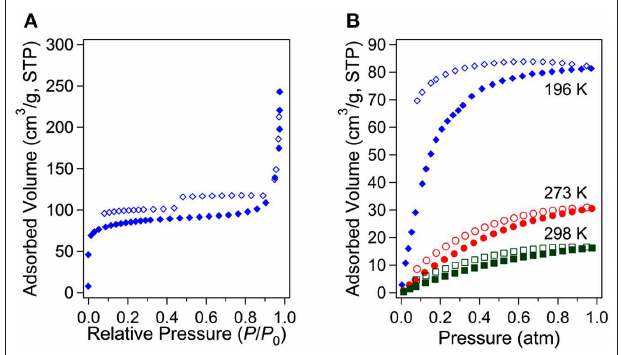
FIGURE 6 | N 2 adsorption/desorption isotherms for the solvent-free I at 77K (A) and CO 2 adsorption/desorption isotherms at three different temperatures (B) .